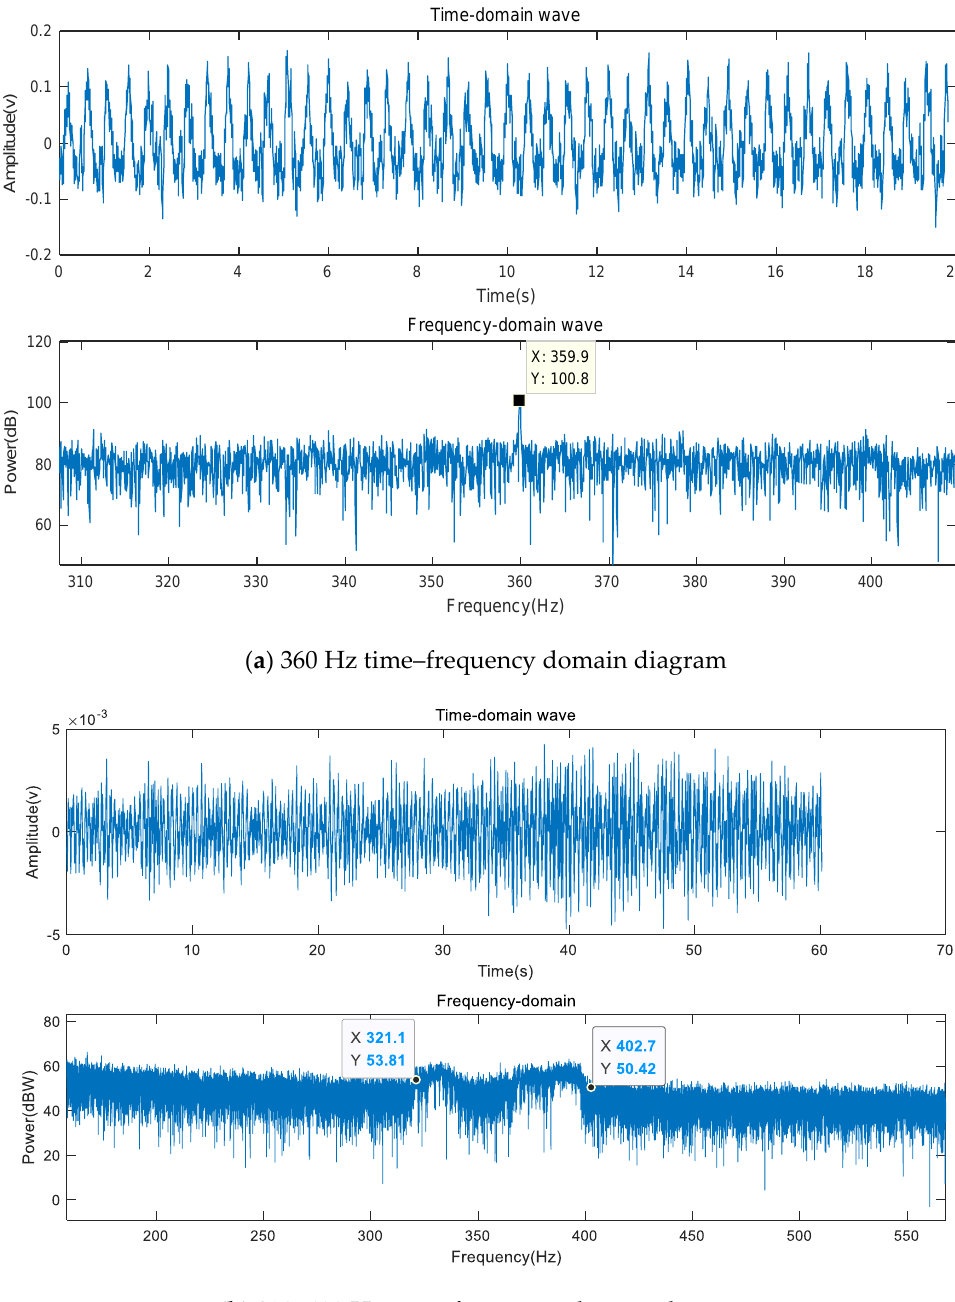
Figure 8. Time – frequency domain diagram. Figure 8. Time–frequency domain